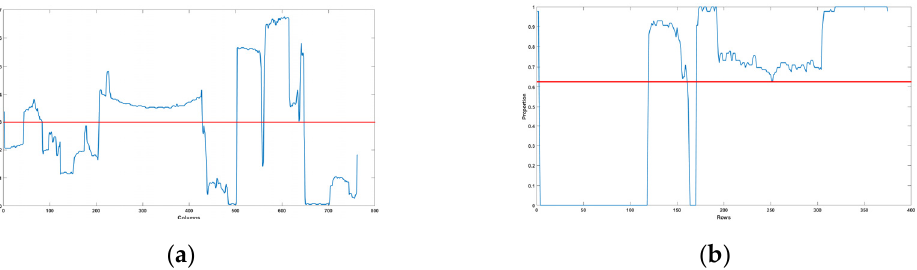
Figure 8. Door extraction process. Red represents the wall surfaces. Black represents the openings. Blue represents the alternative results. Green represents the extraction results. ( a ) is the 2D raster after point cloud projection on the wall surface. ( b ) is the result of ( a ) after morphological open operation. ( c ) is the result after some of the column pixels in ( b ) are filled. ( d ) is the result after some of the row pixels in ( c ) are filled. ( e ) is the result of the door extraction.